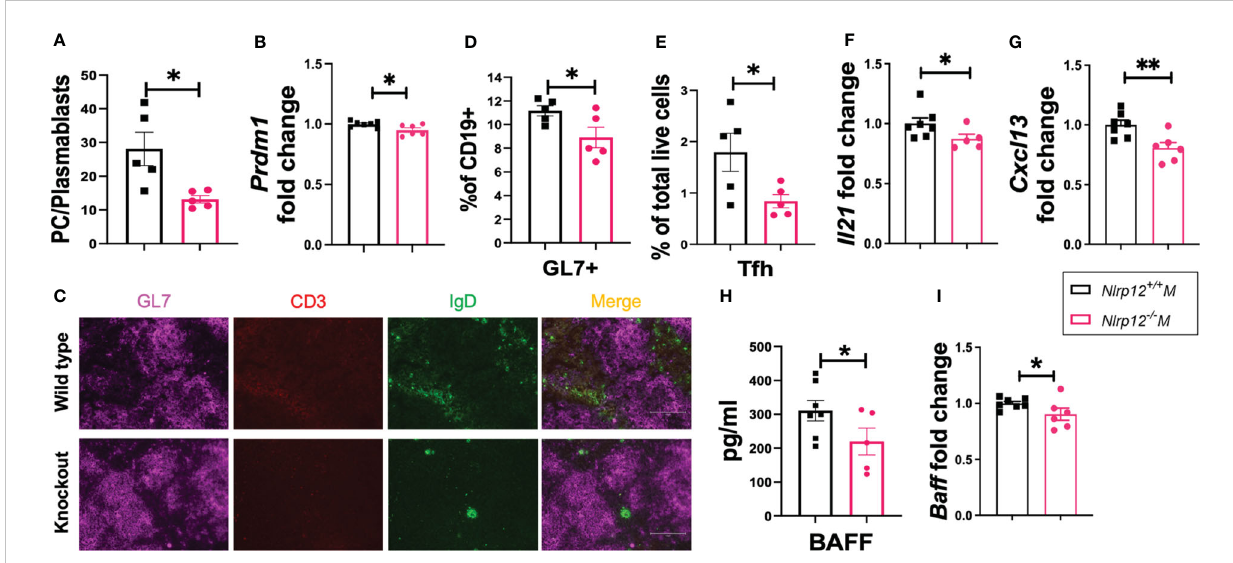
FIGURE 2 Nlrp12 de fi ciency dampens B cell activation and differentiation. Spleens were harvested at the endpoint of 39 weeks of age. (A) The ratio of the frequencies of plasma cells vs . plasmablasts in total splenocytes. (B) Relative transcript level of splenic Prdm1. (C) Immunohistochemical stains of splenic sections with GL7 (purple), CD3 (red), and IgD (green). Pictures were captured with an EVOSVR FL microscope. (D) GL7 + cells as a percentage of splenic CD19 + B lymphocytes as determined with fl ow cytometry. (E) Percentage of Tfh cells in total splenocytes. (F) Relative transcript level of splenic Il21 . (G) Relative transcript level of splenic Cxcl13 . (H) Level of serum BAFF as determined with Luminex assay. (I) Relative transcript level of splenic Tnfsf13b /BAFF. Student ’ s t test was employed for the comparison between two groups. Data are shown as mean ± SEM. Signi fi cant differences were shown as *P<0.05 and **P<0.01.